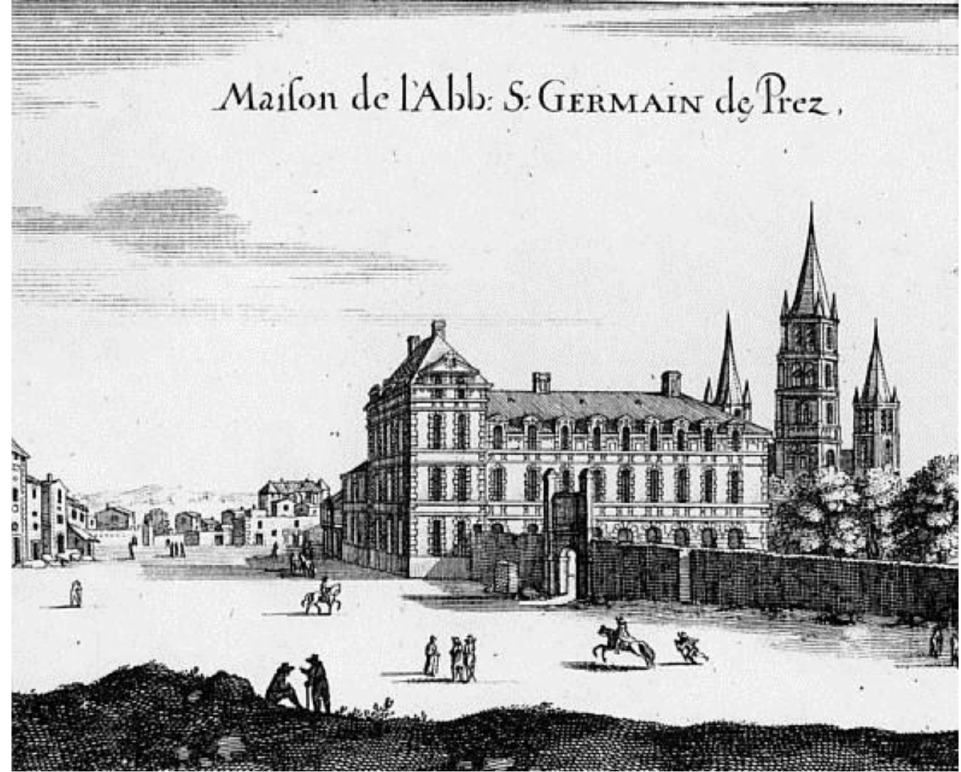
Fig. 3. In 1852, the Academy moved into the old abbey palace of Saint-Germain-des-Prés (3, rue de l ’